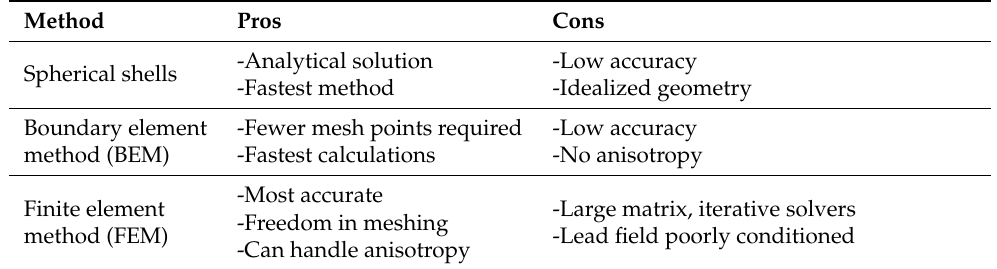
Table 2. Forward problem solution methods, based on